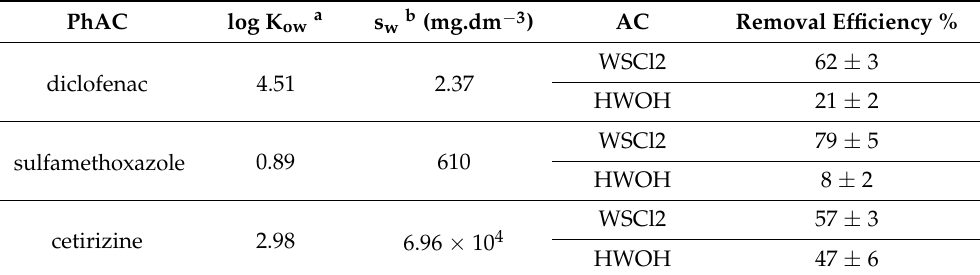
Table 4. Percentage of removal of diclofenac, sulfamethoxazole, and cetirizine from a single PhAC solution in 60 min and their chosen physicochemical